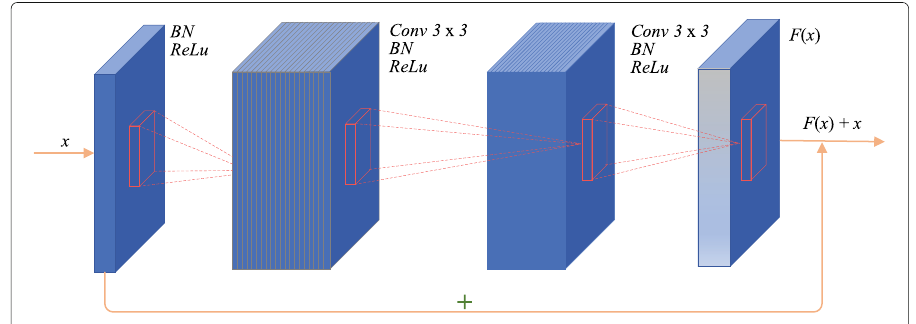
Fig. 2 Flow chart of residual block